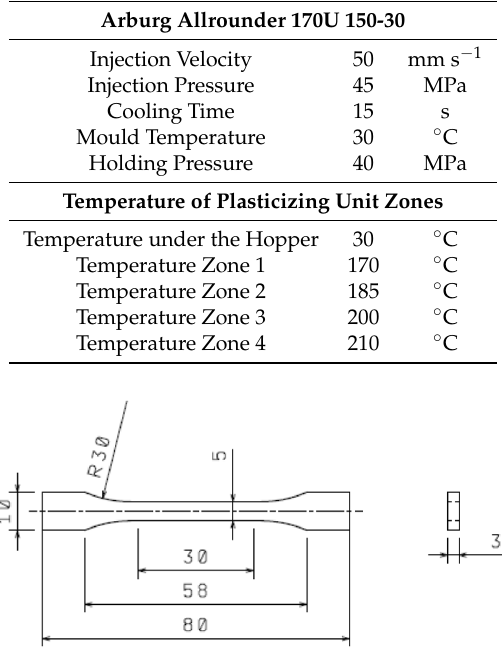
Figure 1. Dimensions of testing